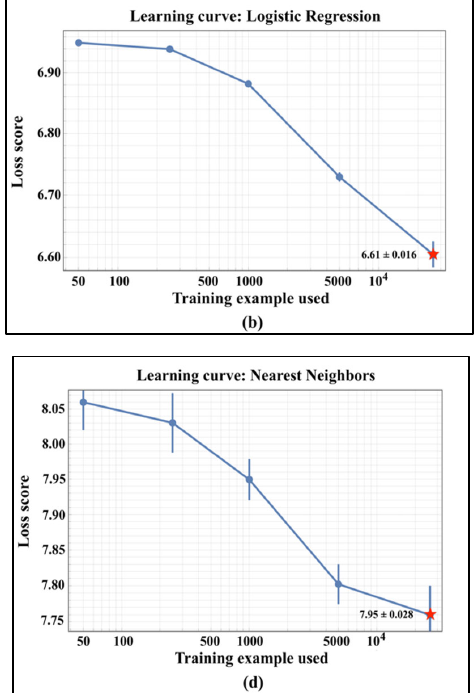
TableForm[Flatten[DeleteCases[Table[Which[StringContainsQ[ToString[keys[[ i ]][[2]]], ToString[ in-